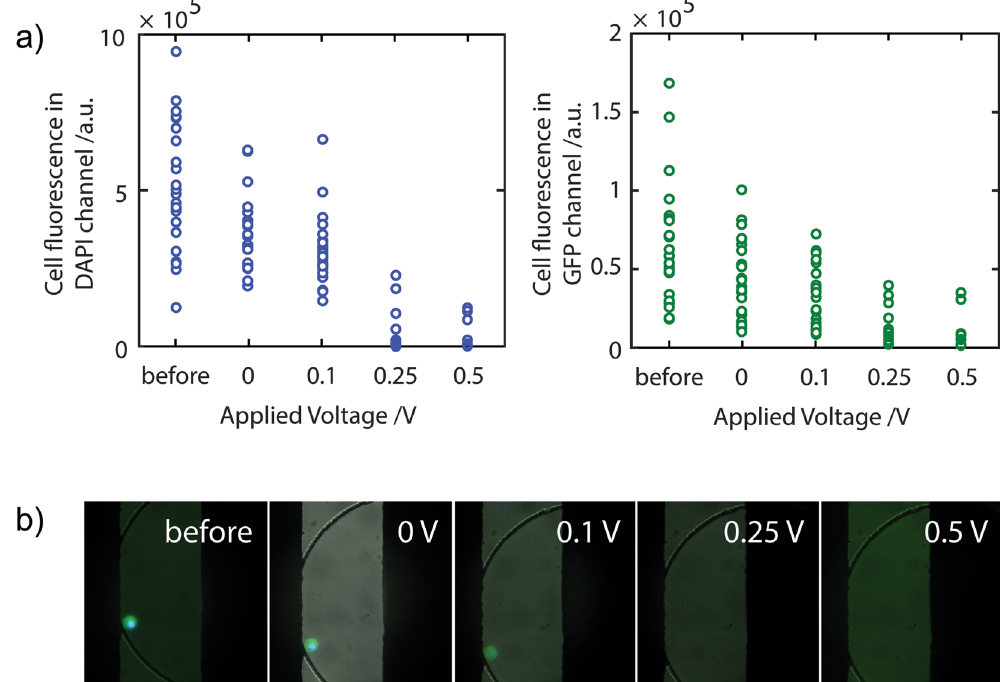
Figure 3. Electrical lysis of cells. ( a ) Using the electrodes, an electric field is applied to the cells within the microwells. An alternating voltage V ac = 10 V pp 1 MHz, superimposed to a constant DC voltage, V DC was applied. The GFP (left plot) and nuclear stain (right plot) fluorescence signal per cell was measured after 5 minute application of the electric field. ( b ) Combined bright field/GFP/H33342 images showing the effects of the electrical field on a cell at each of the DC voltage offsets